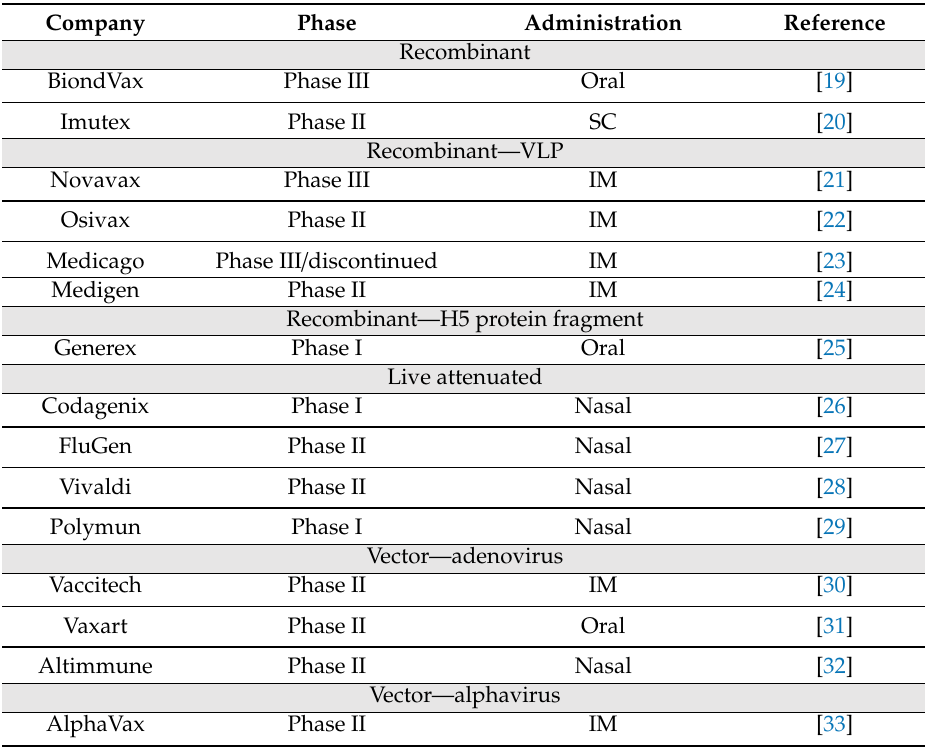
Table 1. Non-egg-based Influenza Vaccines in commercial development that have completed human clinical